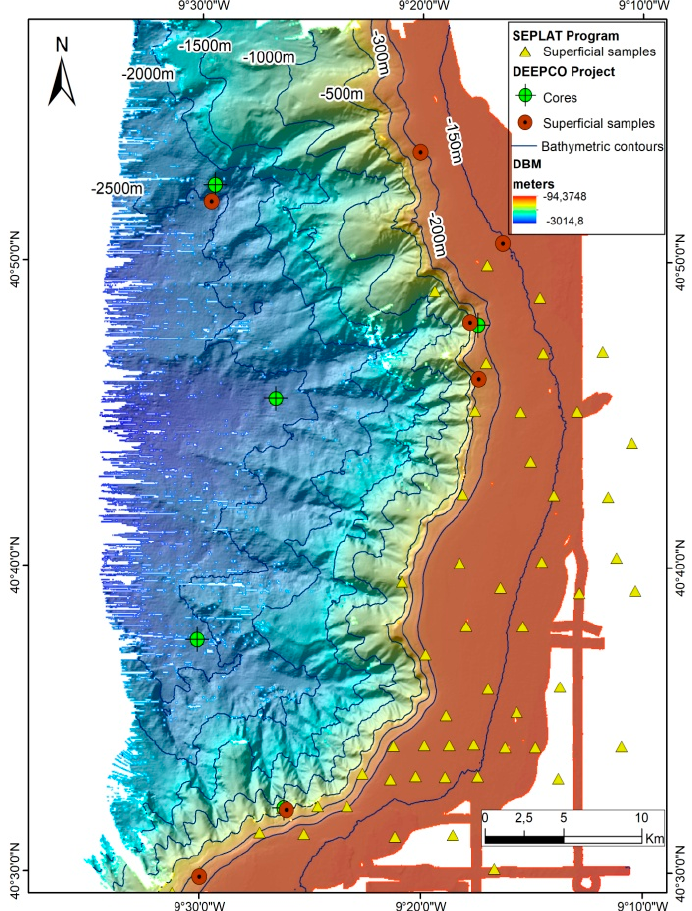
Figure 2. Sediment sampling stations in the upper course of Aveiro Canyon (sampled by the Instituto Hidrográfico, under the scope of the SEPLAT program (Sedimentary Cartography of the Portuguese Continental Platform) and DEEPCO project (West Iberian deep sedimentary conduits)). The black line indicates the location of profile P1 (see Figure 3).